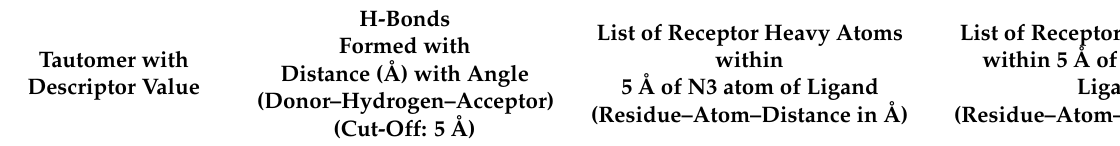
Figure 7. Tautomeric forms of ligand YJA (pdb 4c2v). The red colored numbers have been used for indication of nitrogen atoms involved in tautomerism. Table 3. A comparison of two tautomeric forms, YJA-T1 and